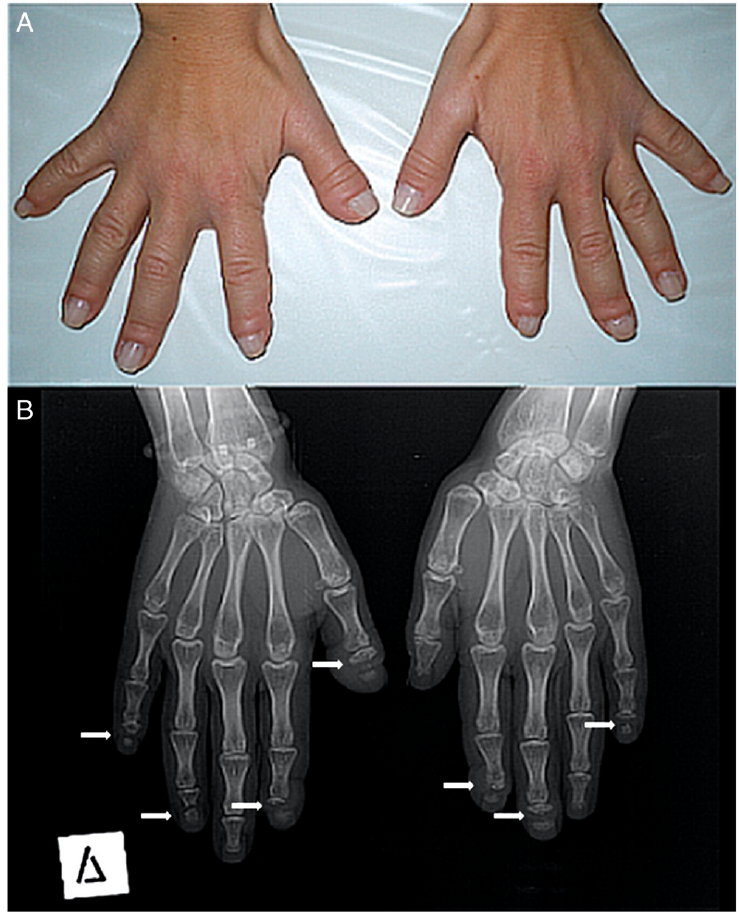
Figure 3. ( A ) Photograph of a patient’s hands. Many of her fingers are thick (predominately the right thumb) with pseudo-clubbing. ( B ) Anteroposterior radiograph of a patient’s hands. Osteolysis of the distal phalanges is found in most of the fingers (only the left thumb, the left fourth, and the right third fingers have a normal appearance). In all lesions, osteolysis has a transverse pattern across the width of the terminal phalanx (white